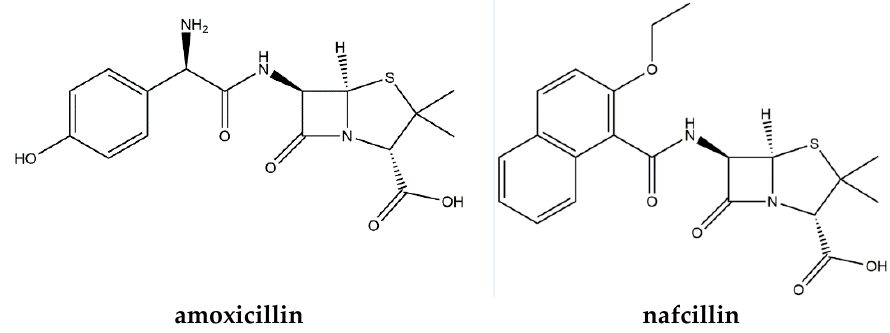
Figure 1. Structures of amoxicillin and nafcillin.